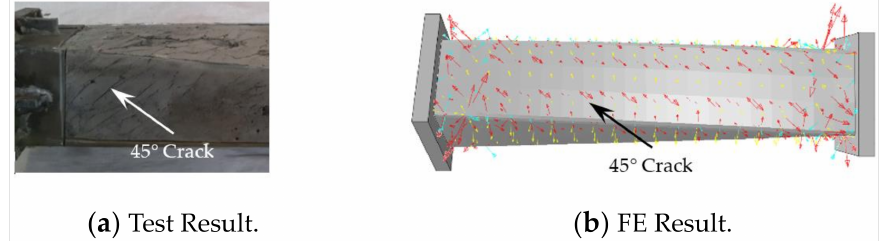
Figure 13. Failure mode of concrete.